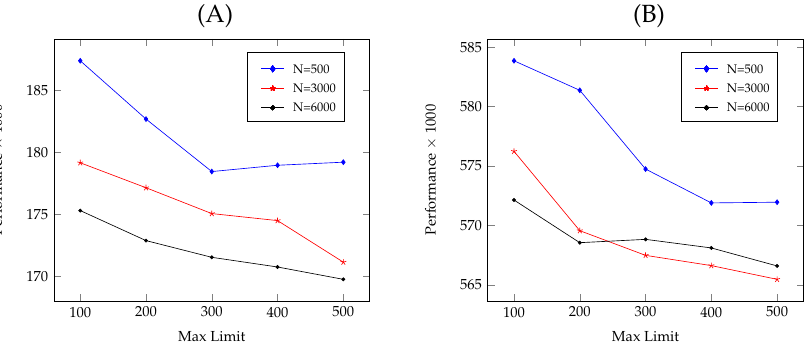
Figure 5. The performance of NSGA-III vs. different MaxLimit for different N for ( A ) t 2 and ( B ) t 5.